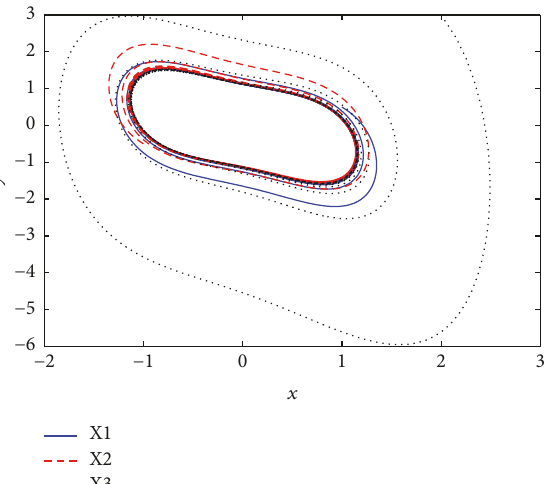
Figure 6: The stable limit-cycle of h − 2 u for unforced Duffing system with three arbitrary initial points x 1,0 = [1,0.5] , x 2,0 = [−1,−0.5] , and x 3,0 = [2,3]